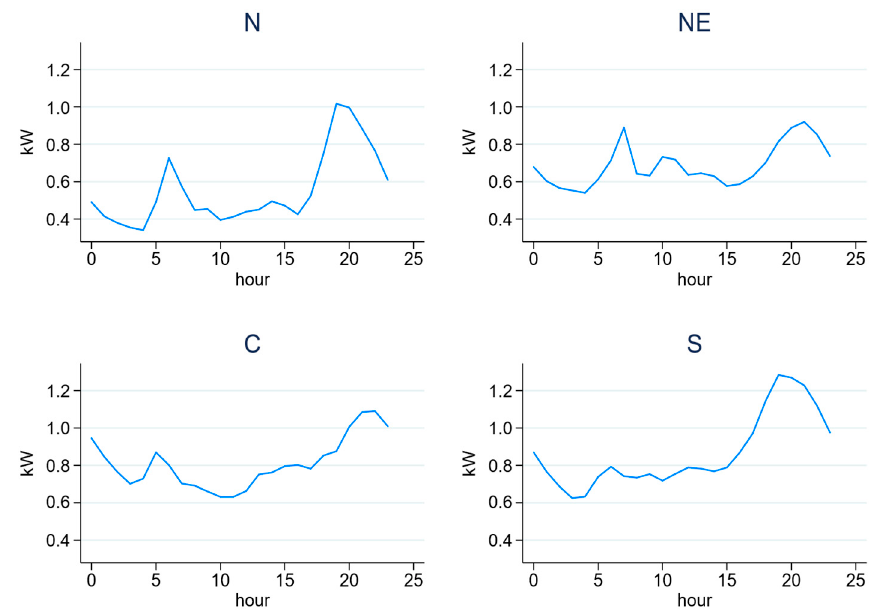
Figure A1. Hourly average load profile of residential customers in Northern region (N), Northeastern region (NE), Central region (C), and Southern region (S).